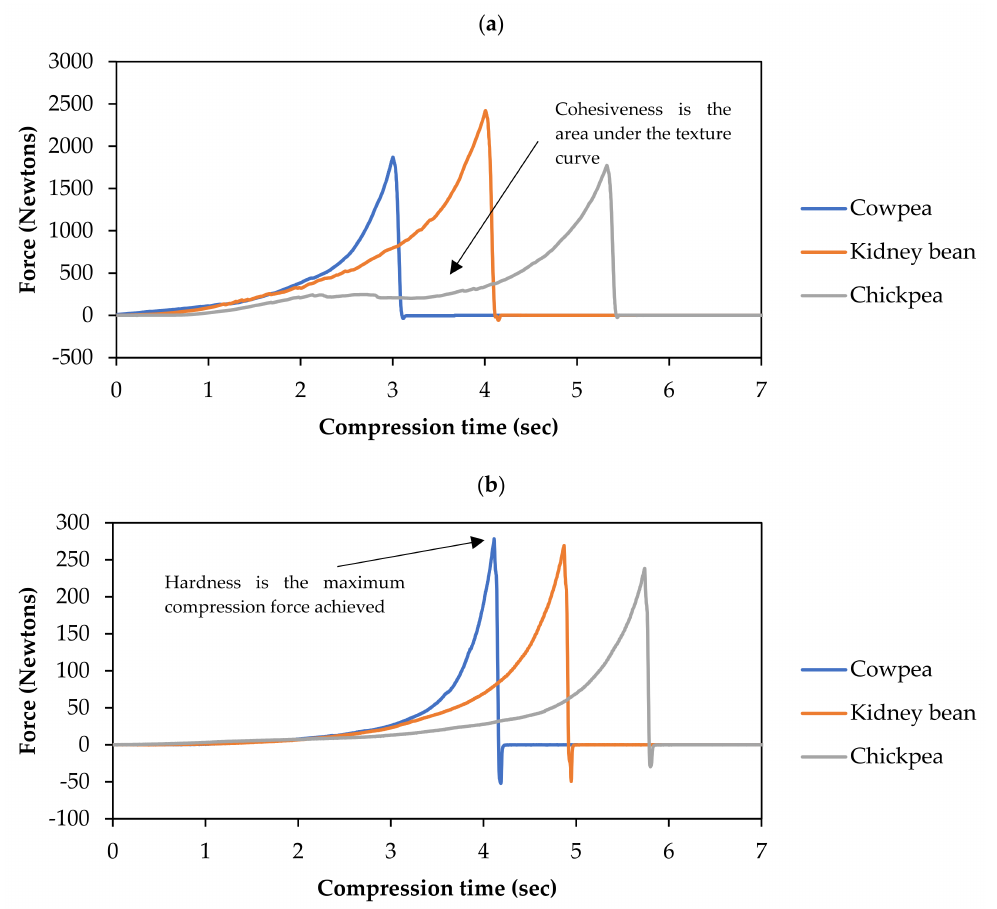
Figure 1. Representative texture profile curves of ( a ) soaked and ( b ) hydrothermally processed ( t c = 120) cowpeas, kidney beans and